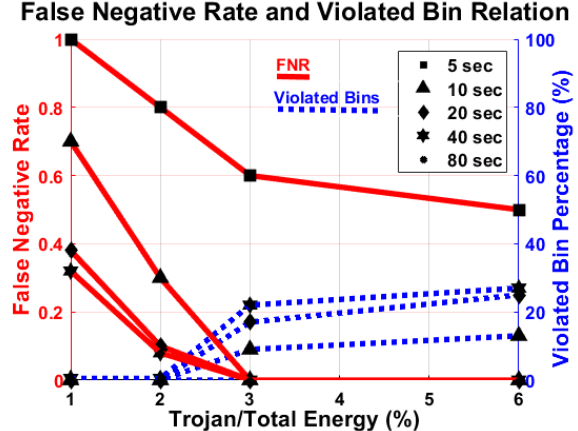
Figure 12. Relation of false negative rate (FNR) (red) and the minimum number of violated bin (blue) with respect to Trojan energy. There are no false